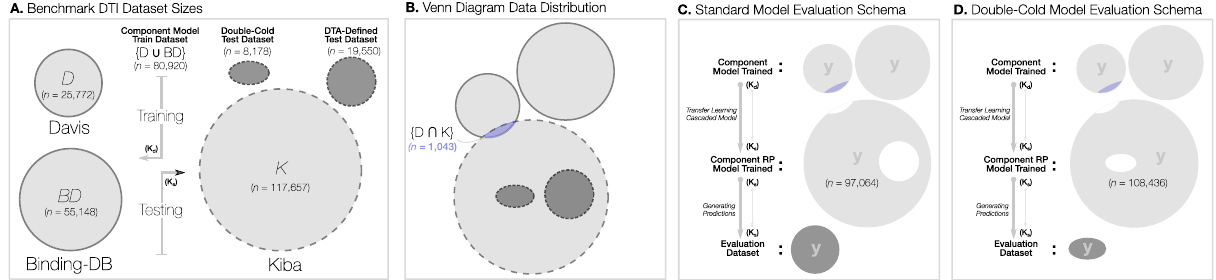
Figure 2. Experimental design to evaluate the proposed MUSDTI